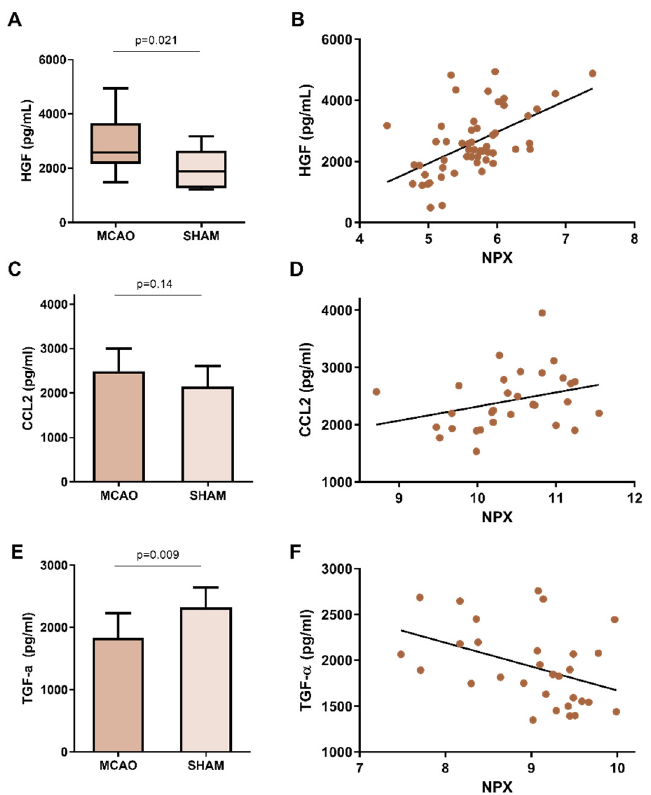
Figure 3. HGF, CCL2 and TGF- α measurements by ELISA. ( A ) Boxplot comparing HGF levels in BALF of MCAO vs. sham mice (N = 49) ( B ) Dotplot representing HGF measurement by Olink ® panel ( X -axis) and measurement by ELISA ( Y axis) (N = 53). ( C ) Boxplot comparing CCL2 levels in lung of MCAO vs. sham mice (N = 30) ( D ) Dot plot representing CCL2 measurement by Olink ® panel ( X axis) and ELISA measurement ( Y axis) (N = 30). ( E ) Boxplot comparing TGF- α levels in lung of MCAO vs. sham mice (N = 30) ( F ) Dot plot representing TGF- α measurement by the Olink ® panel ( X axis) and ELISA measurement ( Y axis) (N = 30). The boxplots showed increased HGF, a trend towards increased CCL2 and decreased TGF-a values in MCAO vs. sham animals, while the scatterplots showed positive correlations for HGF and CCL2 and a negative correlation for TGF-a. HGF: Hepatocyte Growth Factor, CCL2: C-C Motif Chemokine Ligand 2, TGF- α : Transforming Growth Factor α , ELISA: Enzyme-Linked ImmunoSorbent Assay, BALF: bronchoalveolar lavage fluid, NPX: normalized protein expression, MCAO: middle cerebral artery occlusion.